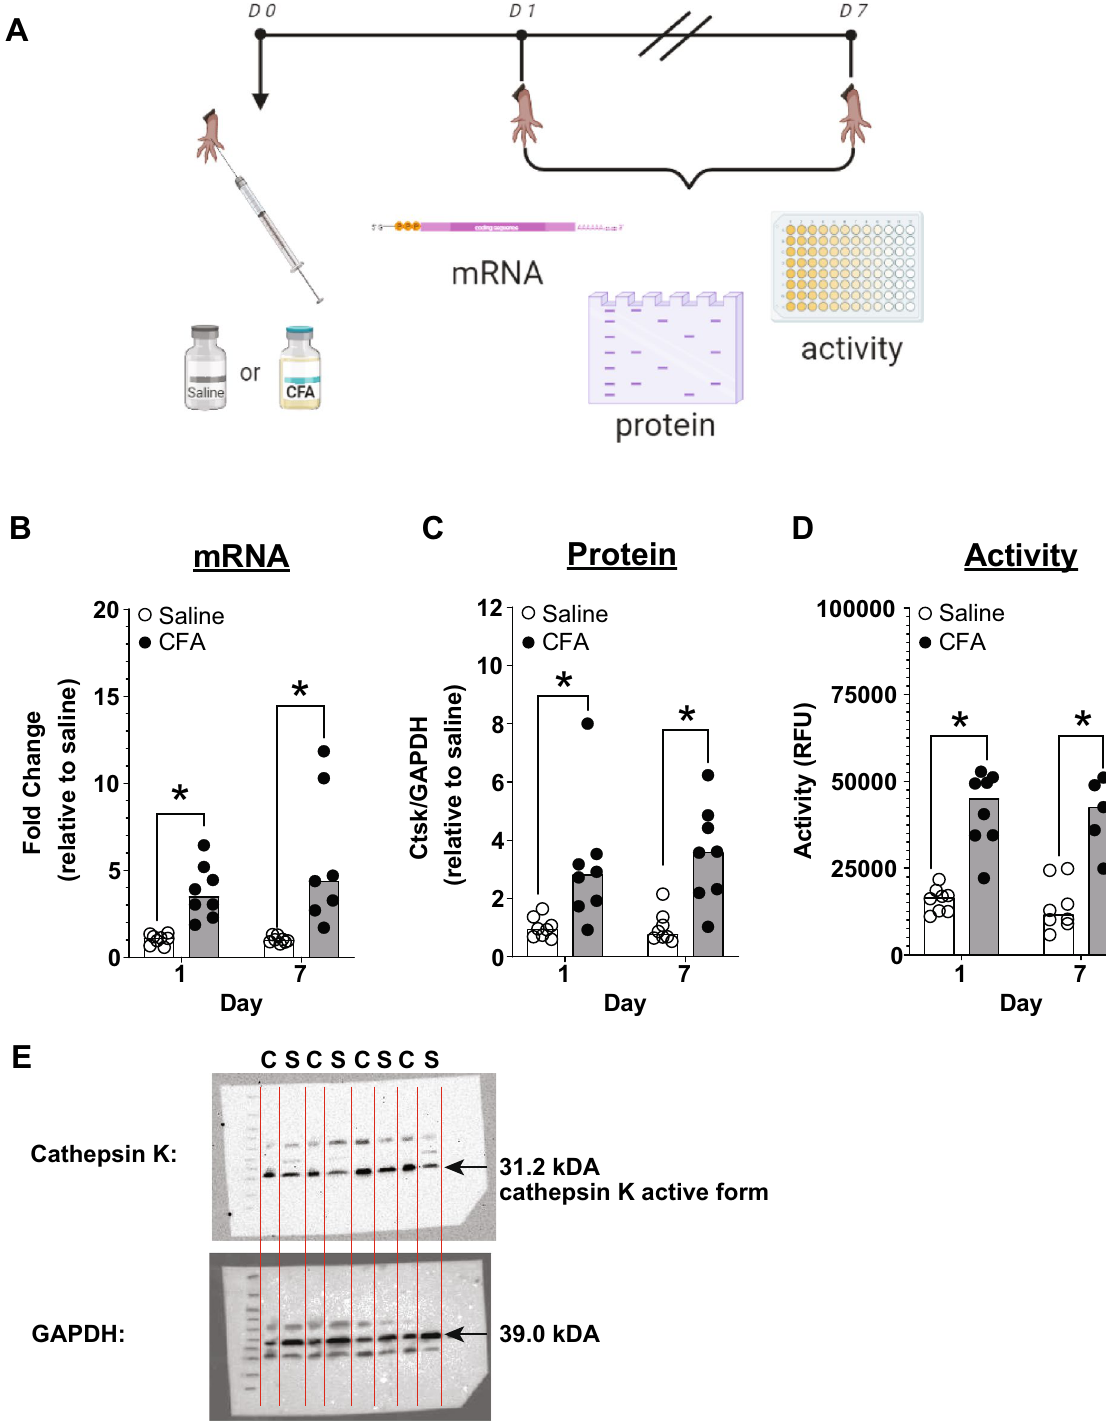
Figure 5. Cathepsin K levels rise post-inflammation in mice. ( A ) Timeline for testing mRNA, protein levels and protein activity. ( B ) There is an increase in cathepsin K mRNA levels in the hind paw after CFA injection. ( C ) Increased cathepsin K protein (active-form) in hind paw after CFA injection. ( D ) In addition, there is an increase in cathepsin K activity in the hind paw after CFA injection. ( E ) Representative western blot of cathepsin K and housekeeping protein GAPDH after CFA injection. Black arrow indicates the molecular weight of detected protein. CFA and Saline treated samples are represented as C and S, respectively. Data are represented at scatter plots of individual mice with bar graphs overlayed indicating the median value. *p < 0.05 Mann– Whitney test between saline and CFA treatment on day 1 and day